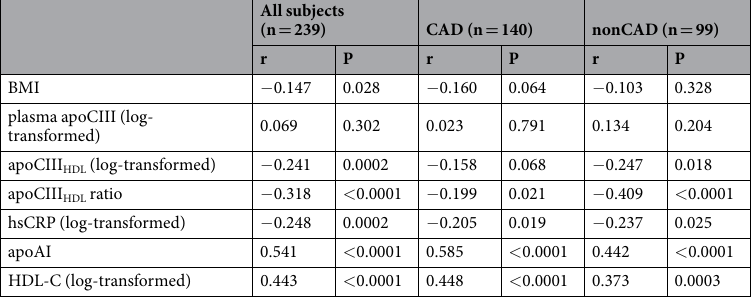
All subjects (n = 239) CAD (n = 140) nonCAD (n = 99)